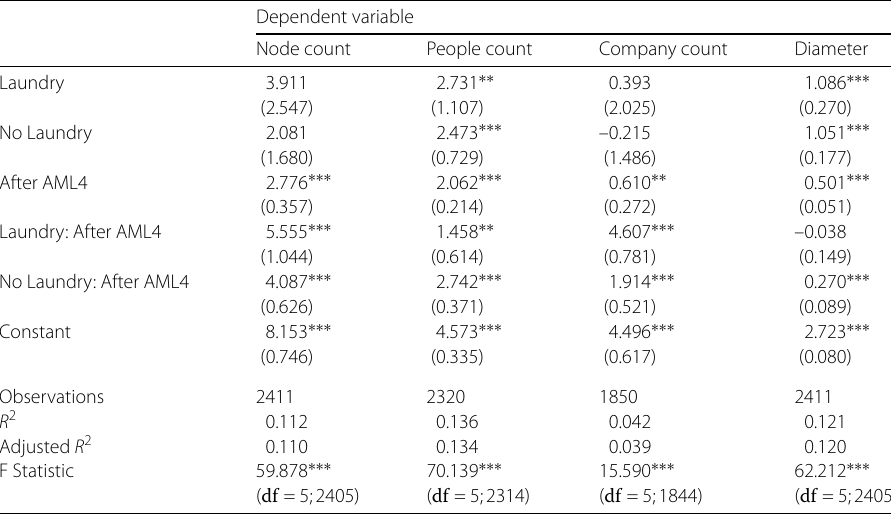
Table 4 Results of random effects regressions on cluster size Dependent variable Node count People count Company count